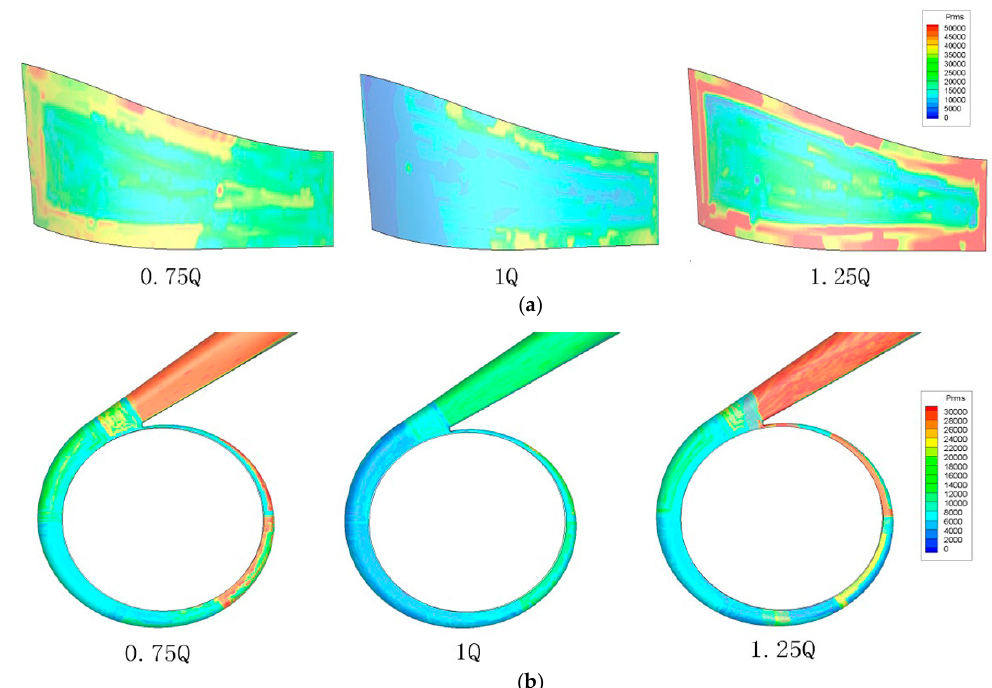
Figure 8. Distribution of root mean square (RMS) value on both impeller and volute under three separate flow rates, including 0.75 Q, 1 Q and 1.25 Q. ( a ) Distribution of RMS value on impeller; and ( b ) distribution of RMS value on volute.